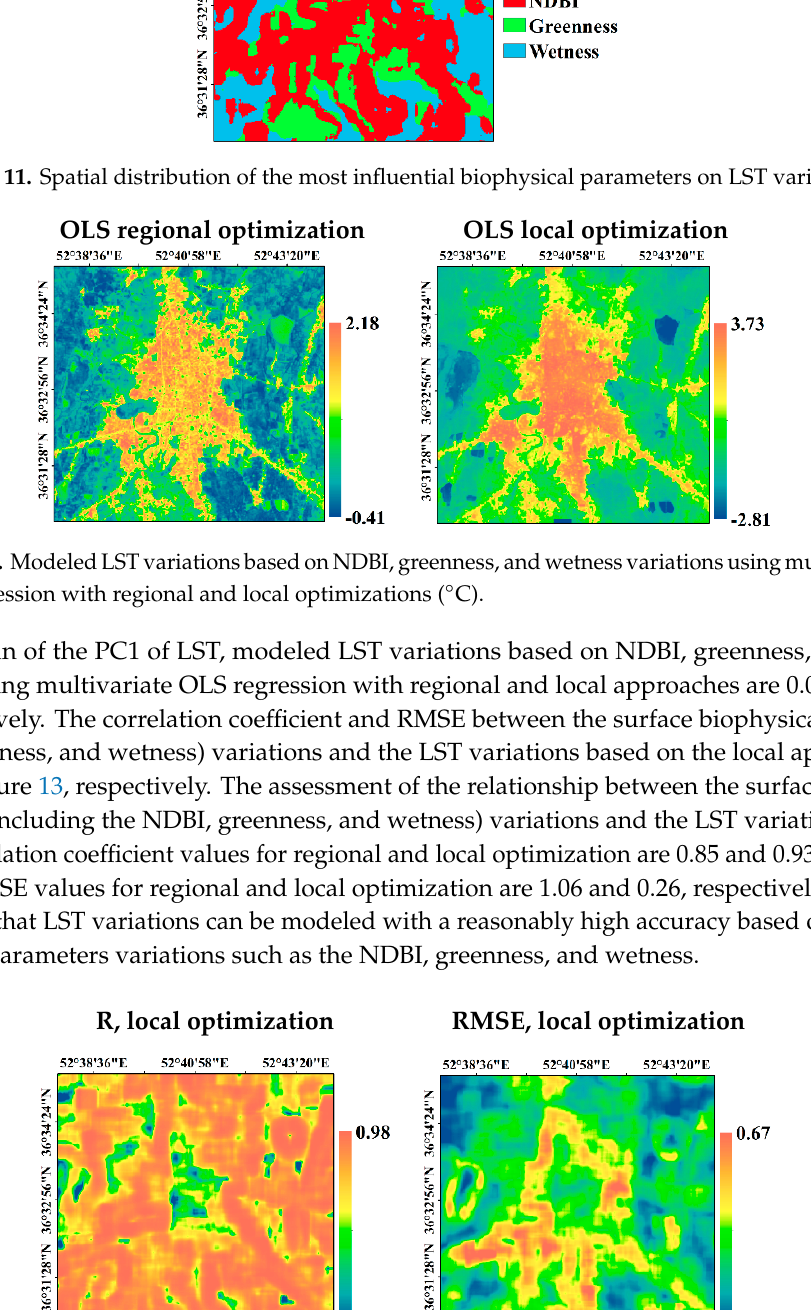
Figure 13. The correlation coefficient and RMSE between the surface biophysical parameters variations and the LST variations based on the local approach.